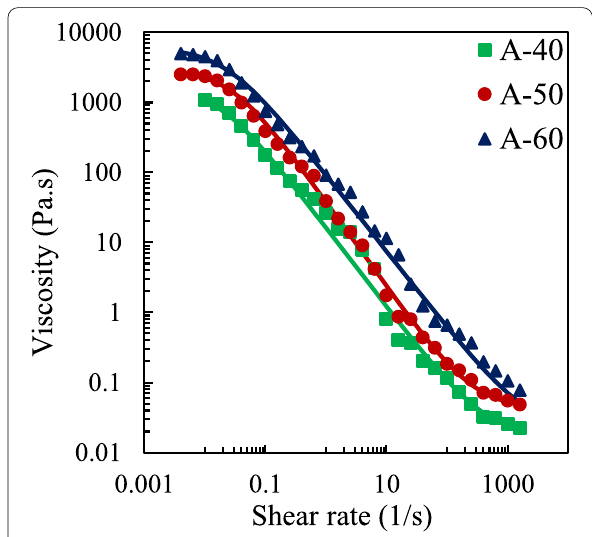
Fig. 10 Viscosity of studied asphalt emulsions with different solid content